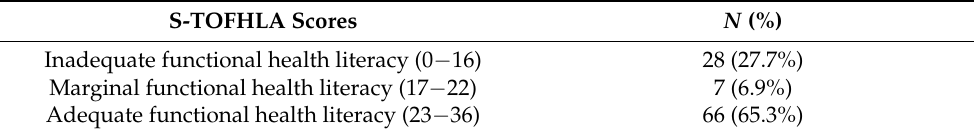
Table 2. The percentage distribution of the sample’s FHL levels in the S-TOFHLA. S-TOFHLA Scores N (%) Inadequate functional health literacy (0 − 16) 28 (27.7%) Marginal functional health literacy (17 − 22) 7 (6.9%) Adequate functional health literacy (23 − 36) 66 (65.3%)